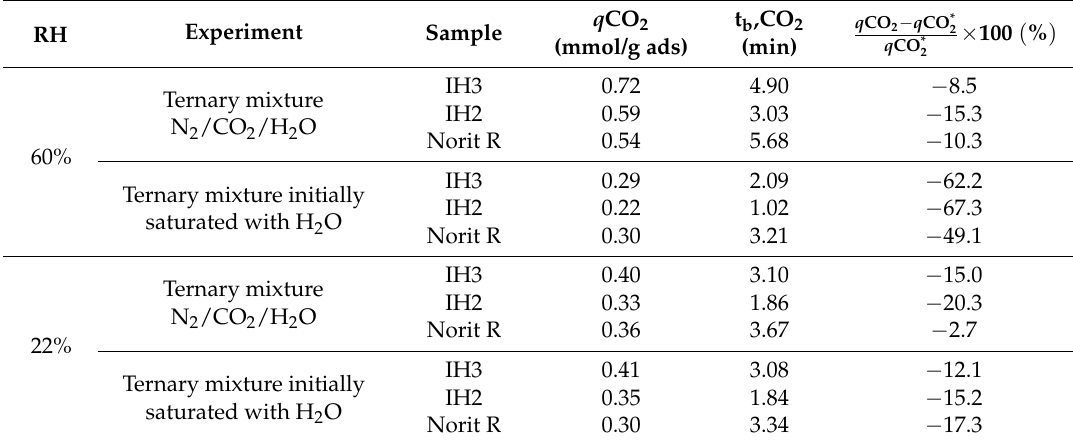
Figure 11. CO 2 breakthrough curves for ternary N 2 /CO 2 /H 2 O mixtures over a fully regenerated adsorbent bed (blue) and ternary mixtures fed to the adsorbent initially saturated with H 2 O (red) at 30 ◦ C ( a,c,e ) and 50 ◦ C ( b,d,f ). Table 8. Results of CO 2 uptake capacity and breakthrough times for the ternary breakthrough experiments at low and high relative